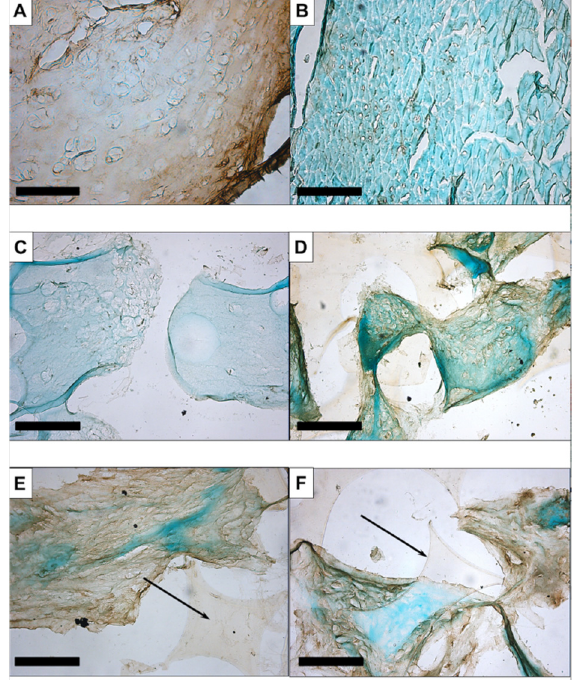
Figure 3. Immunohistochemistry with anti-collagen II: An even brown staining of the extracellular matrix of human septal cartilage resulted ( A ), whereas the negative control, muscular tissue ( B ), and the cell-seeded PU-fibrin construct maintained in EM-DMEM showed no brown colouration ( C ). The treated groups revealed weak staining in the BBT-treated group ( D ) and visible brown staining in the BT ( E ) and TI ( F ) group. Magnification is ×200 in all figures; the scale bar represents 100 µ m.